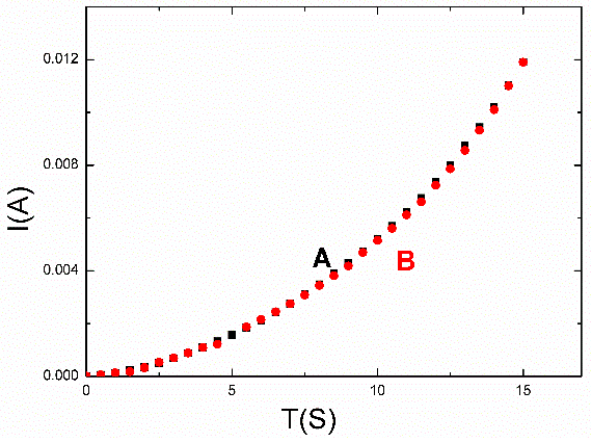
Figure 5. Stability tests of the sensor. The I–V characteristics of the sensor are shown at the origin state (curve A) and after being left for six months (curve B).